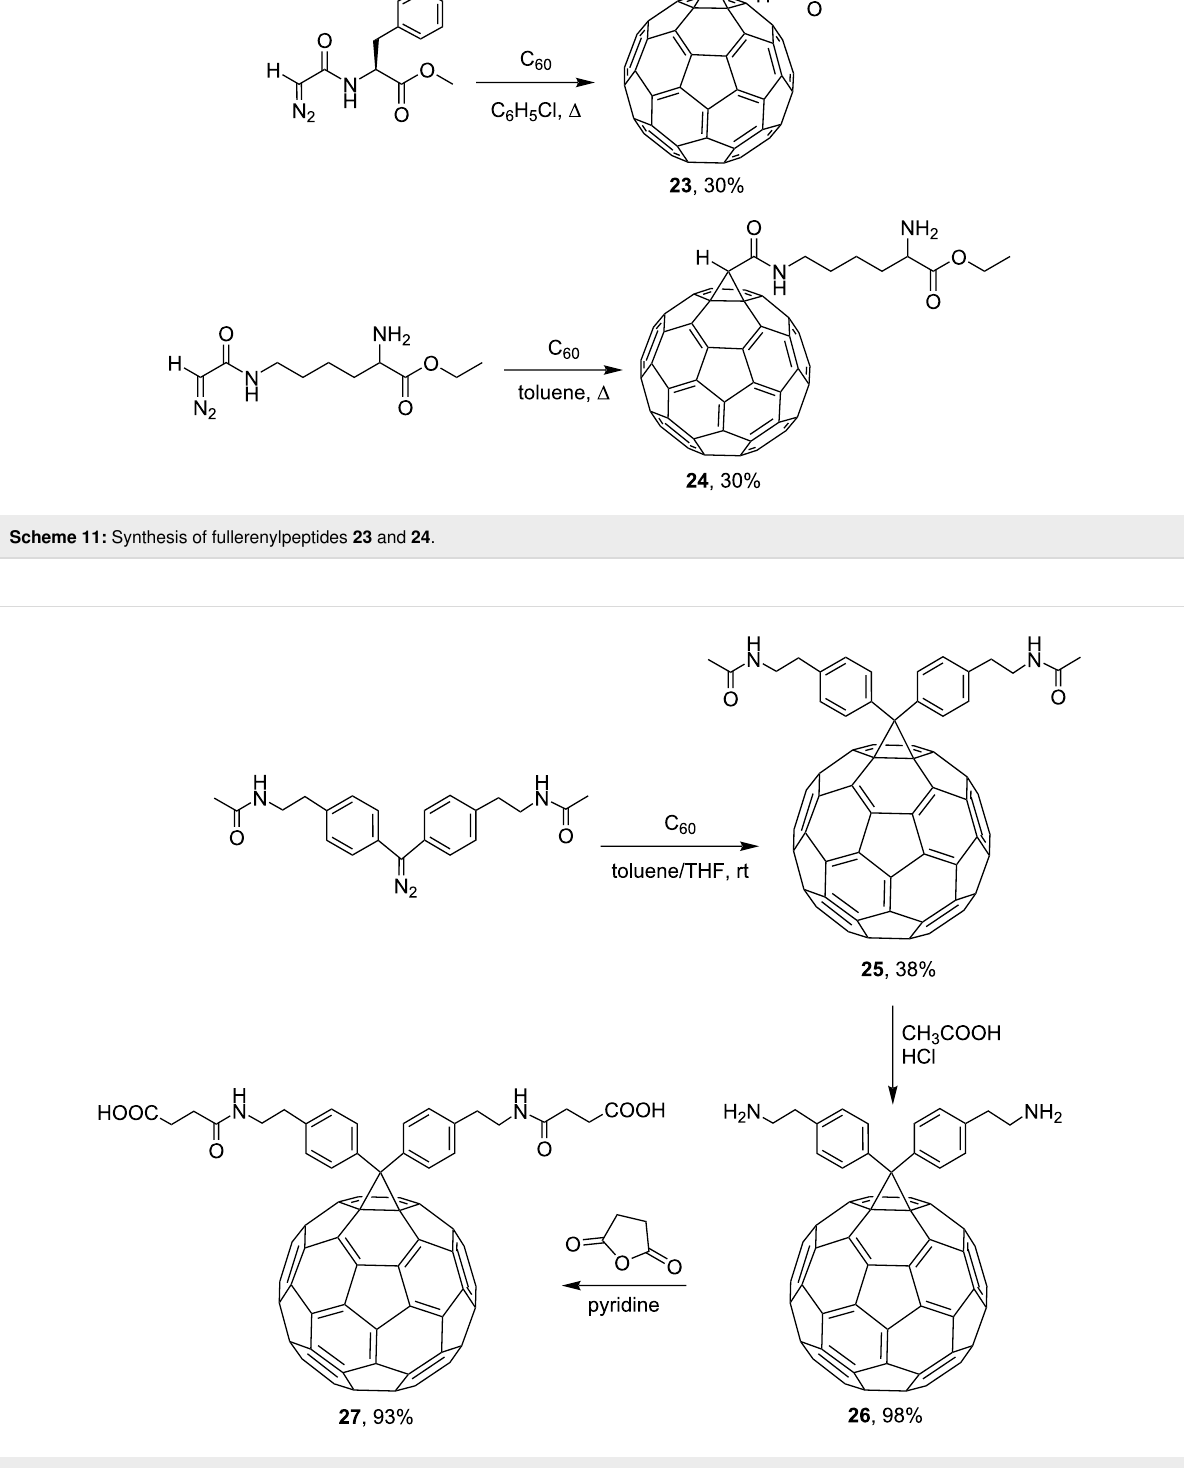
Scheme 12: The synthetic route to the water-soluble biologically active fullerene–peptide derivative 27